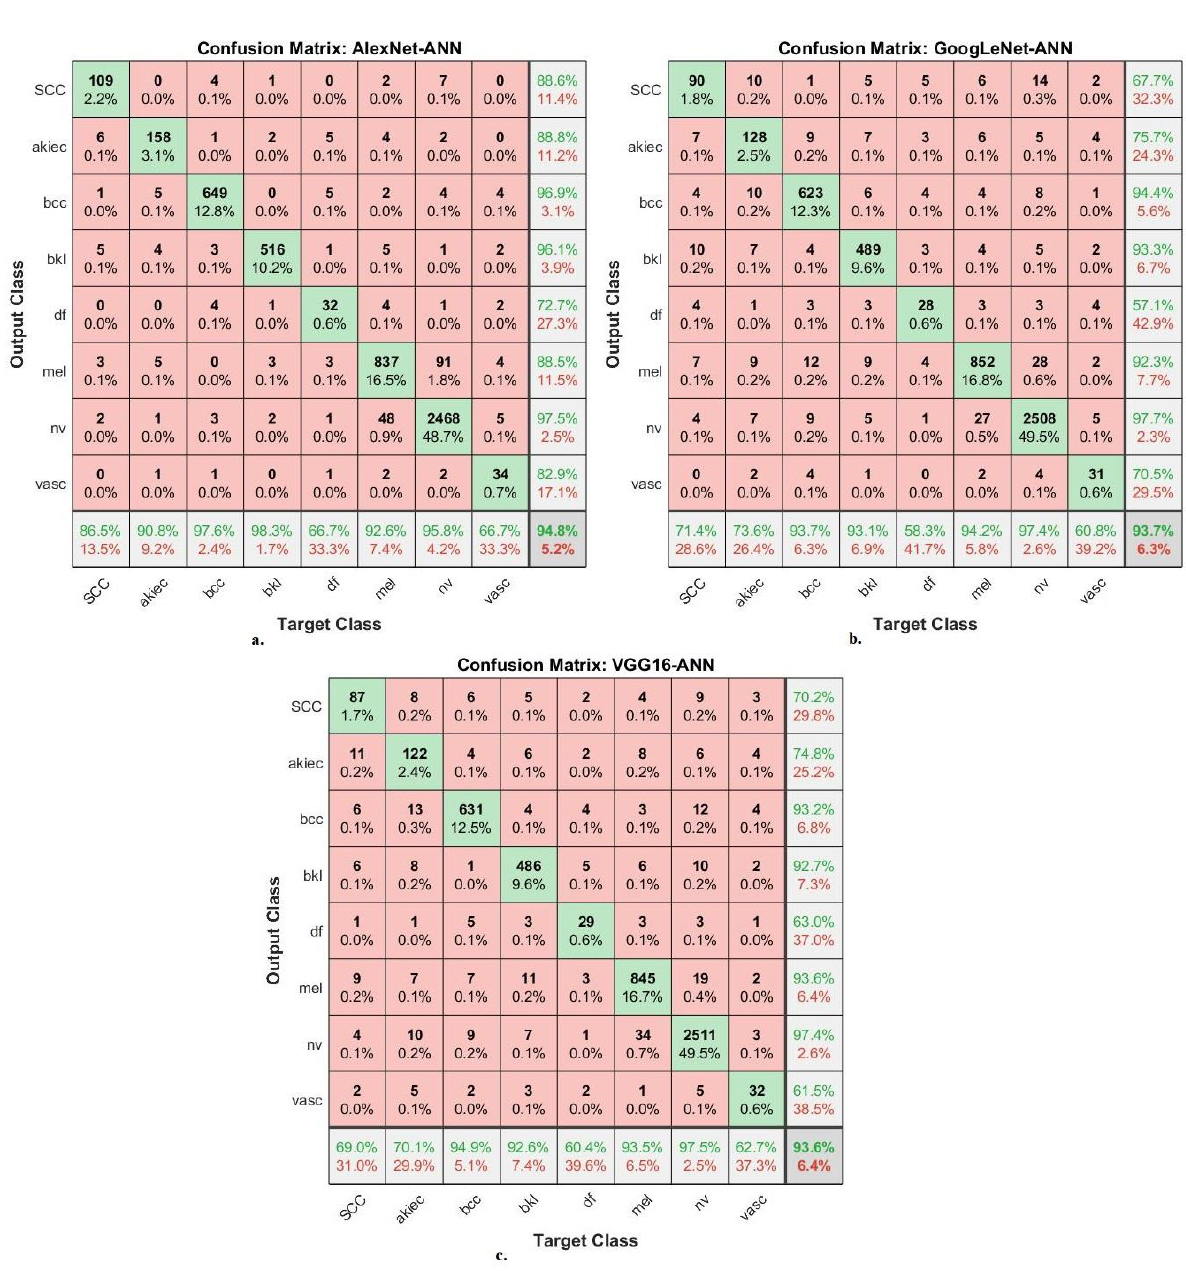
Figure 11. Confusion matrix for displaying performance results of hybrid CNN-ANN models based on ROI using the GAC method for early diagnosis and discrimination of skin cancer from other skin